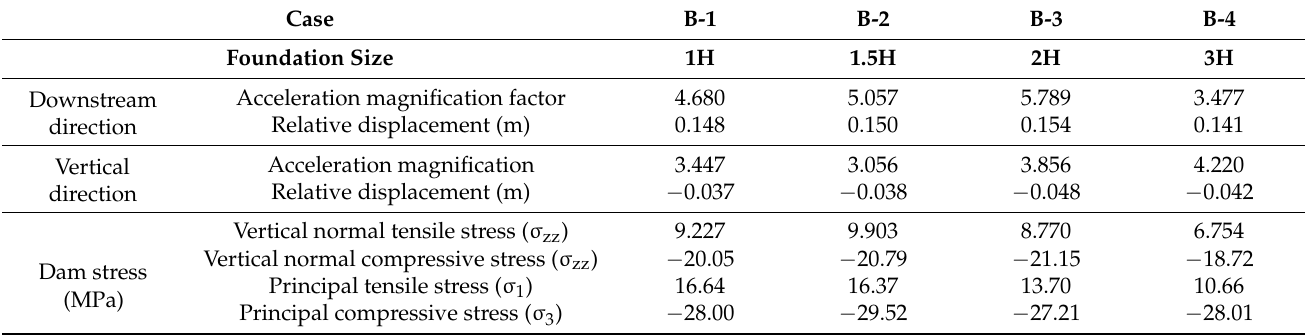
Table 4. The extreme values of dam dynamic response for different foundation sizes